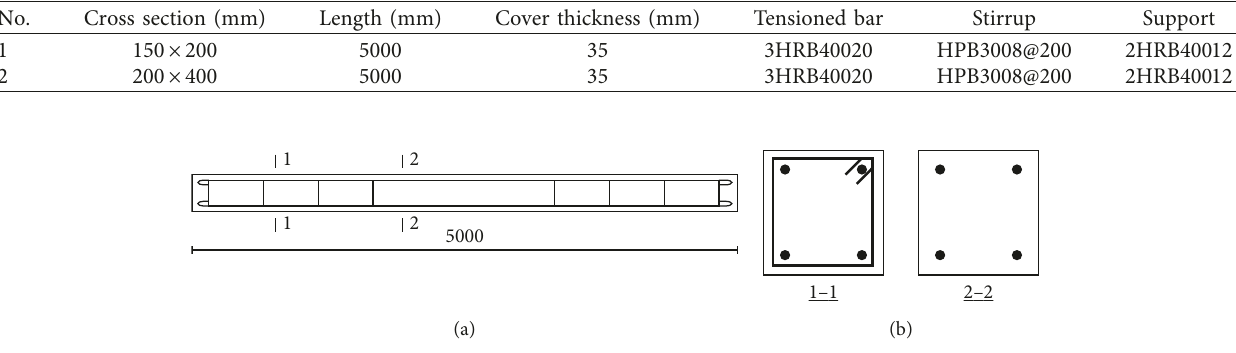
Figure 4: Geometrical model of coal gangue geopolymer concrete beam. (a) Geometrical size. (b) Steel bars distribution.